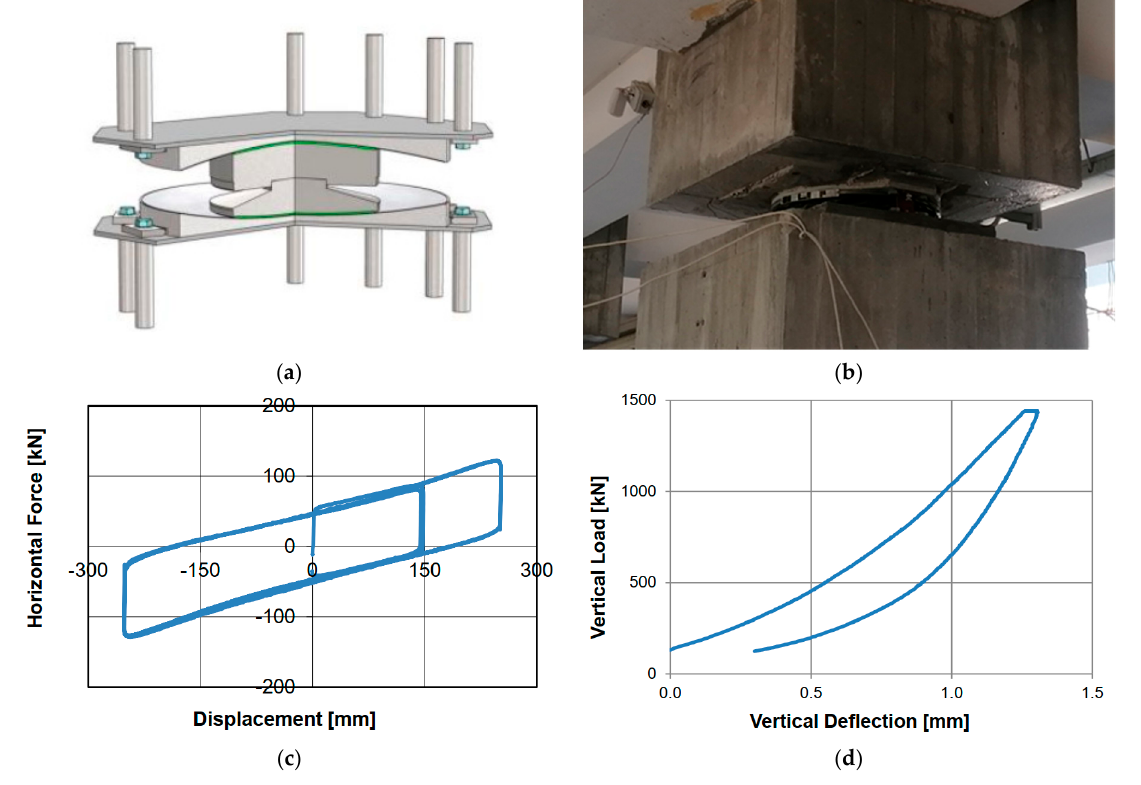
Figure 3. Isolation system in use for the present study: ( a ) cross-sectional schematic view and ( b ) in- situ installation in the Frangipane School in Reggio Calabria (detail), with ( c ) experimental response under horizontal and ( d ) vertical forces.